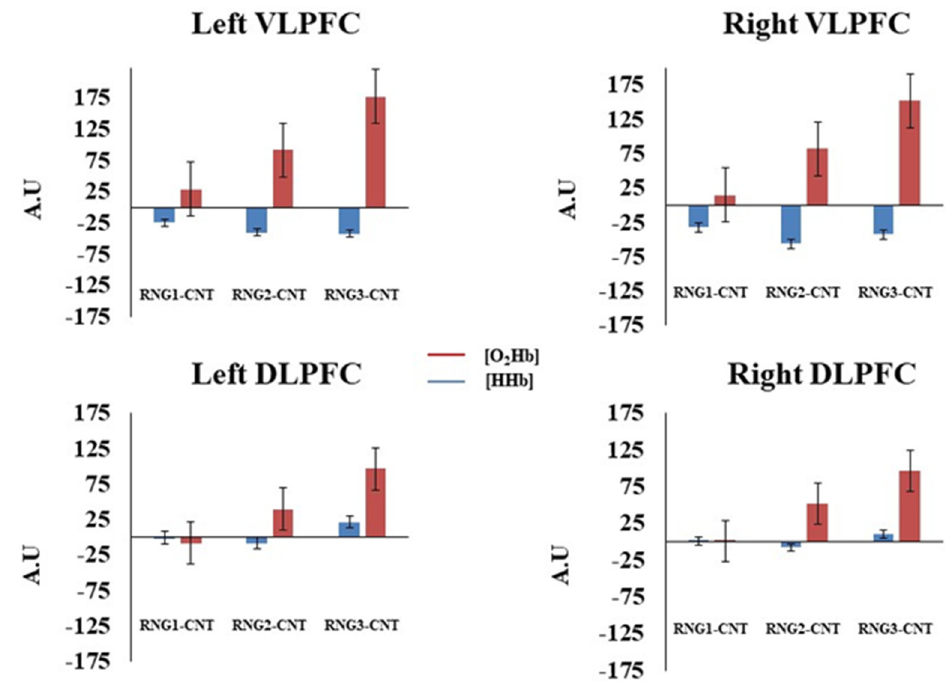
Figure 5. Hemodynamic concentration changes in the prefrontal cortex as a function of cognitive load, hemisphere, and channel during random number generation. Bars represent standard error. RNG1-CNT = activation 1; RNG2-CNT = activation 2; RNG3-CNT = activation 3; VLPFC = ventrolateral prefrontal cortex; DLPFC = dorsolateral prefrontal cortex.